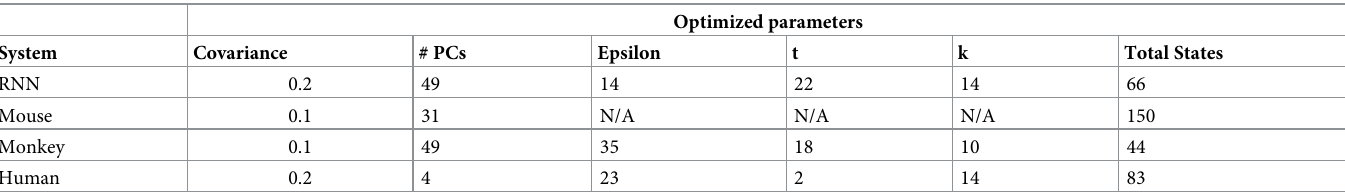
Table 3. Hidden Markov model